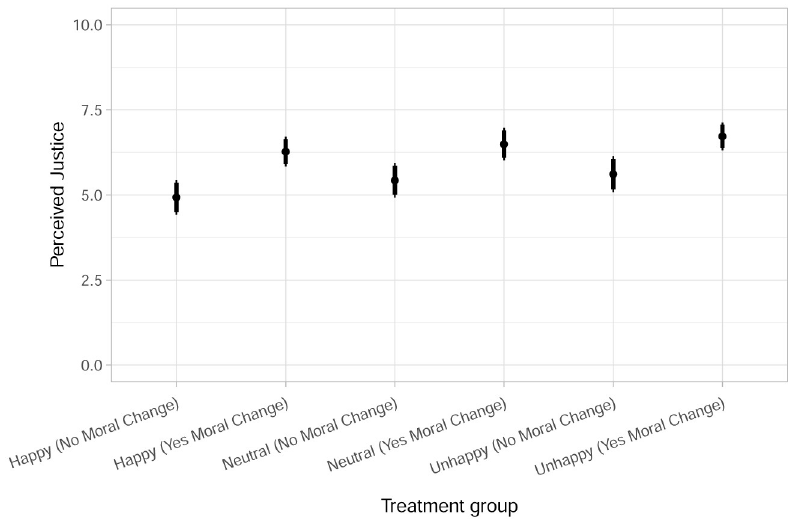
Fig 5. Perceived justice across treatment groups. Graph displays 95%- and 90%- confidence intervals as thinner and thicker bars; Data: original data.